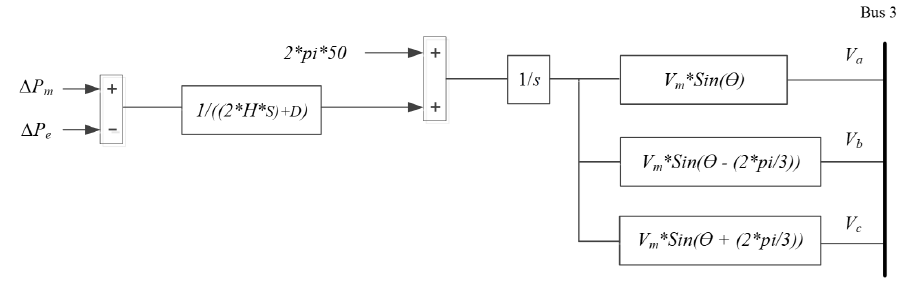
Figure 8. Block diagram for dynamic v/f equivalent of the rest of